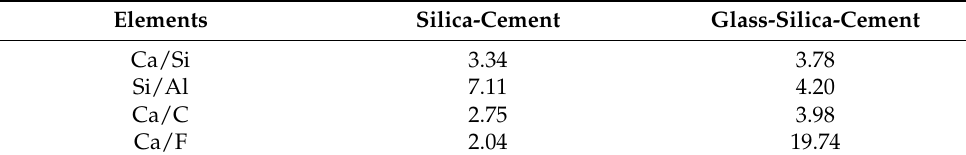
Table 4. Elemental ratio in silica fume and glass-blended silica-fume paste.